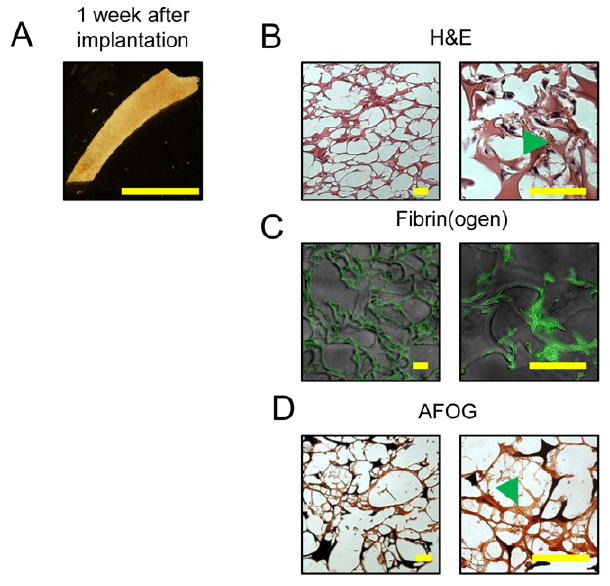
Figure 5. Gelfoam gels loaded with rPN become encased with fibrin-rich hydrogels after intrapericardial injection in pigs. (A) Cross-sectional photomicrograph of the explanted Gelfoam disk 7 days after implantation. (B–D) Explanted Gelfoam disks were characterize d with hematoxylin and eosin (H&E, B), immunofluorescent staining for fibrinogen (C) acid-fuschin orange-G (AFOG, D). Green arrows indicate fibrin deposition. Scale bars, (A) 20 mm; (B–D) 50 m m.